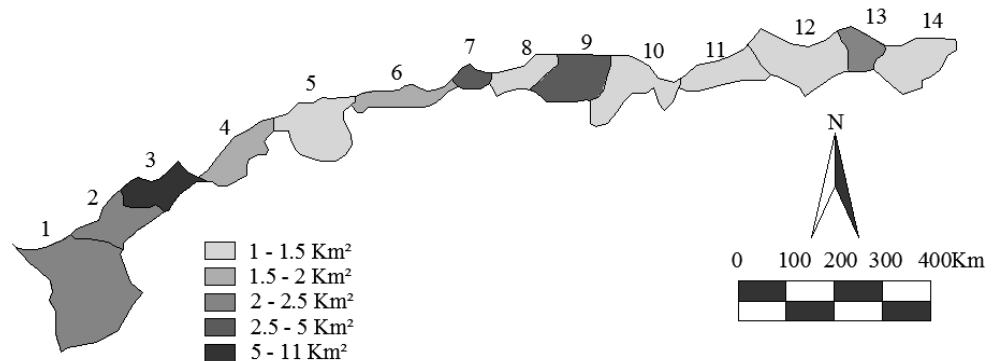
Figure 18. Urbanization of the Algerian coast during 2009-2015 by department: 1—Tlemcen, 2—Ain Temouchent, 3—Oran, 4—Mostaganem, 5—Chlef, 6—Tipaza, 7—Alger, 8—Boumerdes, 9—Tizi Ouzou, 10—Béjaia, 11—Jijel, 12—Skikda, 13—Annaba, 14—El Taref. Source: made by W.H. using official data. The darker shading (in the Western part) indicates a more intense urbanization.